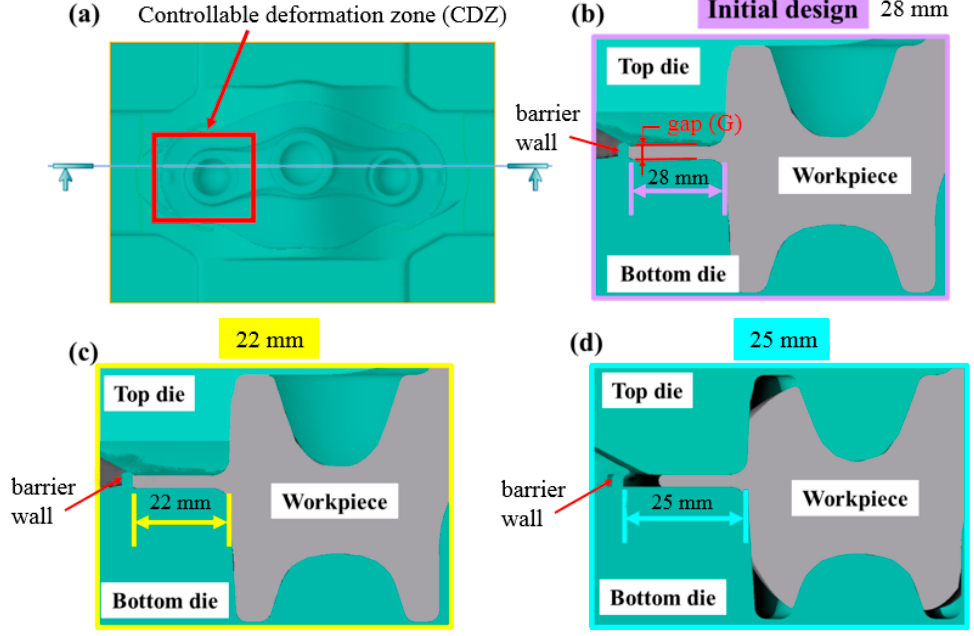
Figure 5. Optimization analysis of the preforming die, ( a ) A cross-sectional view of aluminum crown forging; ( b ) original BWD: 28 mm; ( c ) improved BWD: 22 mm; ( d ) improved BWD: 25 mm.